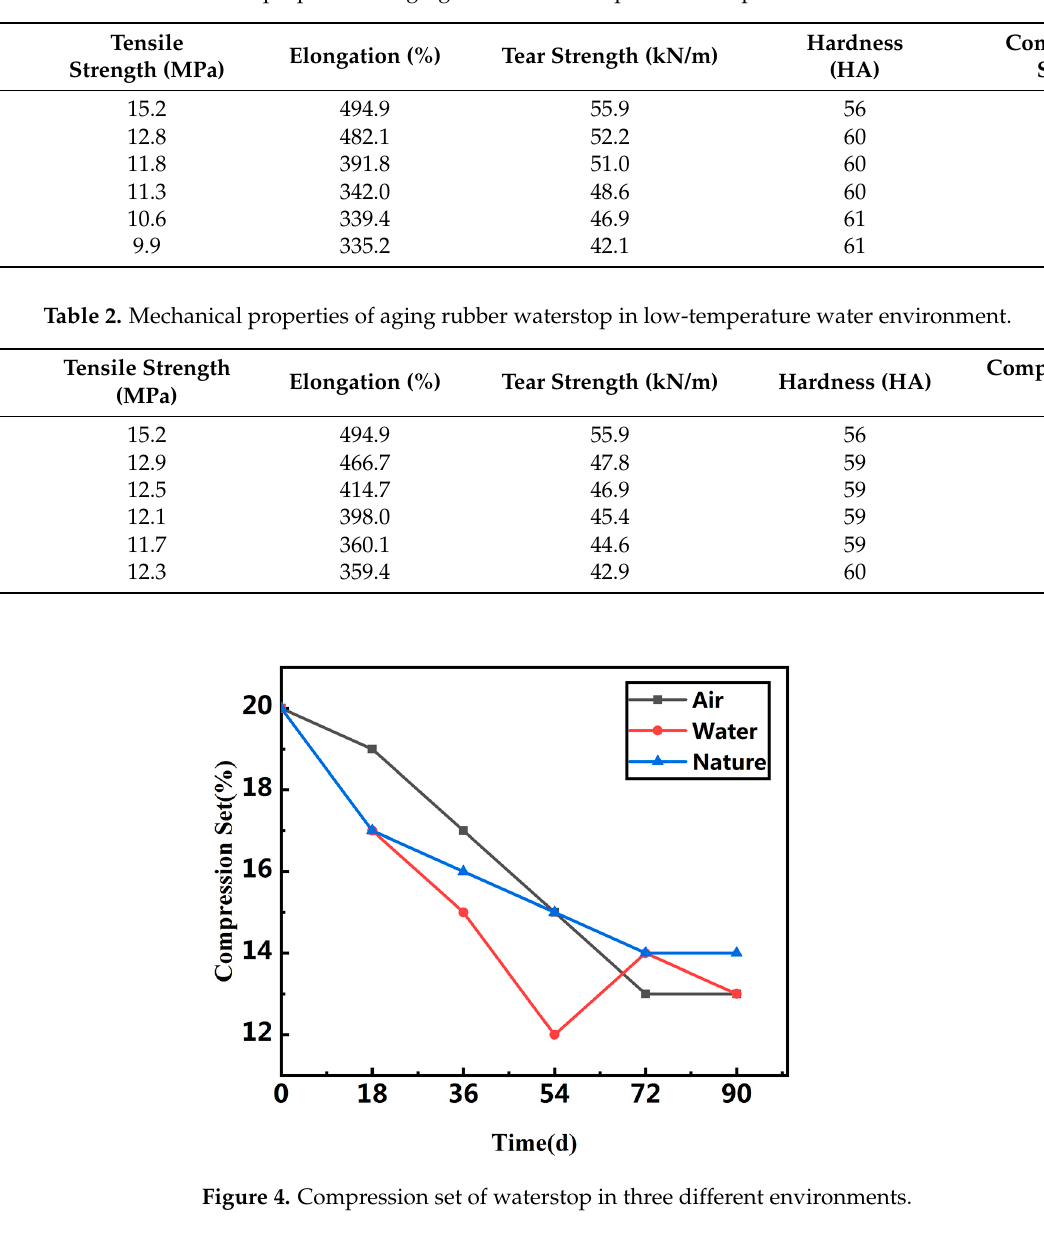
Table 1. Mechanical properties of aging rubber waterstop in low-temperature air environment.